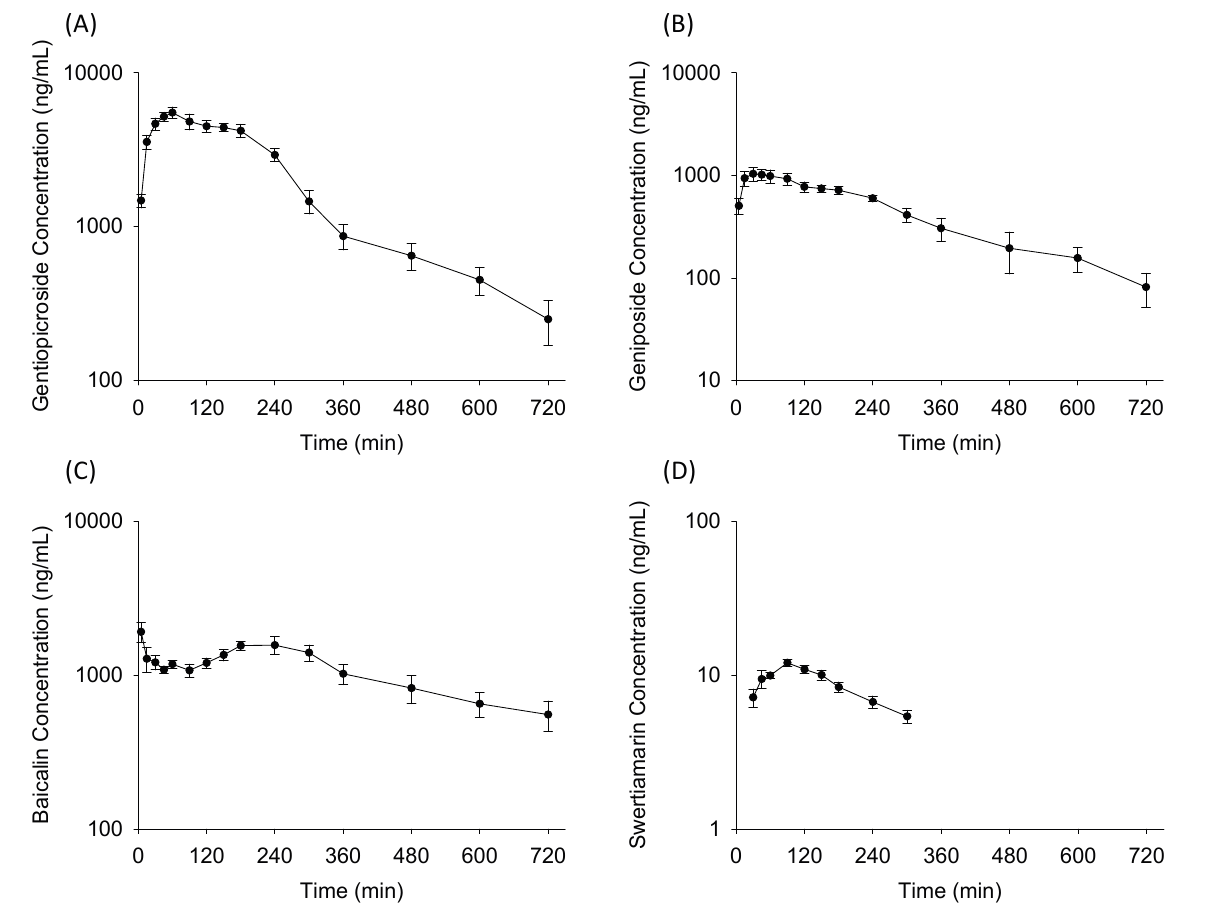
Figure 3. Mean plasma concentration-time profile of ( A ) gentiopicroside; ( B ) geniposide; ( C ) baicalin; and ( D ) swertiamarin in rat plasma after oral administration of Long-Dan-Xie-Gan-Tang (LDXGT; 10 g/kg). The herbal contents of LDXGT are gentiopicroside 17.04 mg/g, geniposide 25.08 mg/g, baicalin 9.94 mg/g, and swertiamarin